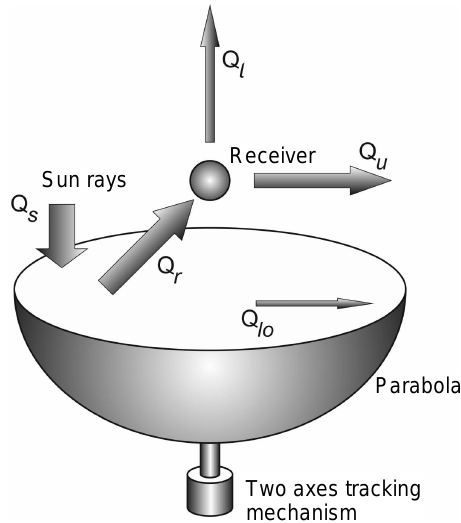
Figure 2. Energy balance of the solar dish concentrator (adapted from Thakkar,